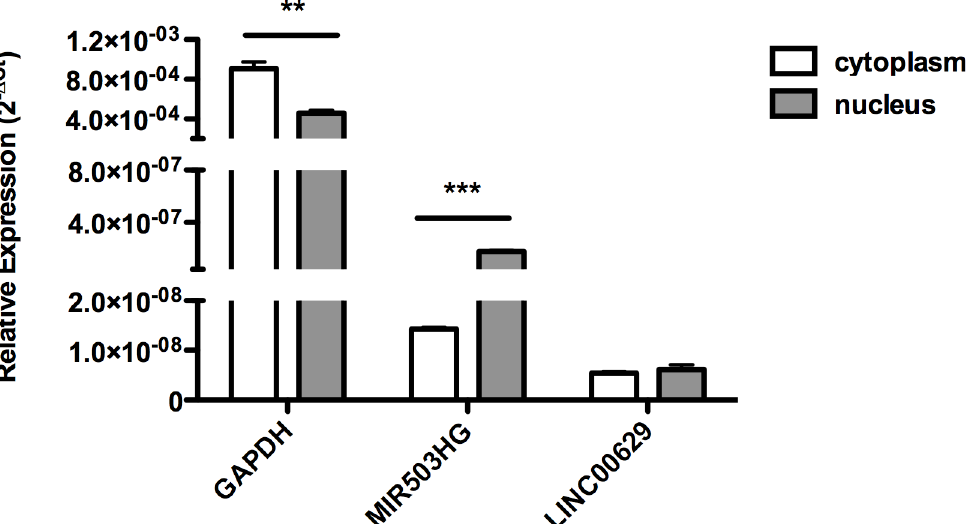
Fig 8. Cellular location of MIR503HG and LINC00269 RNAs. RNA samples were extracted from nuclear and cytoplasmic fractions of JEG3 cells. RT- qPCR obtained relative expression from three experiments normalized to 18S ribosomal RNA. GAPDH fits as a control of predominantly cytoplasmic genes. ** p < 0.01 and *** p < 0.001 ( t -test).